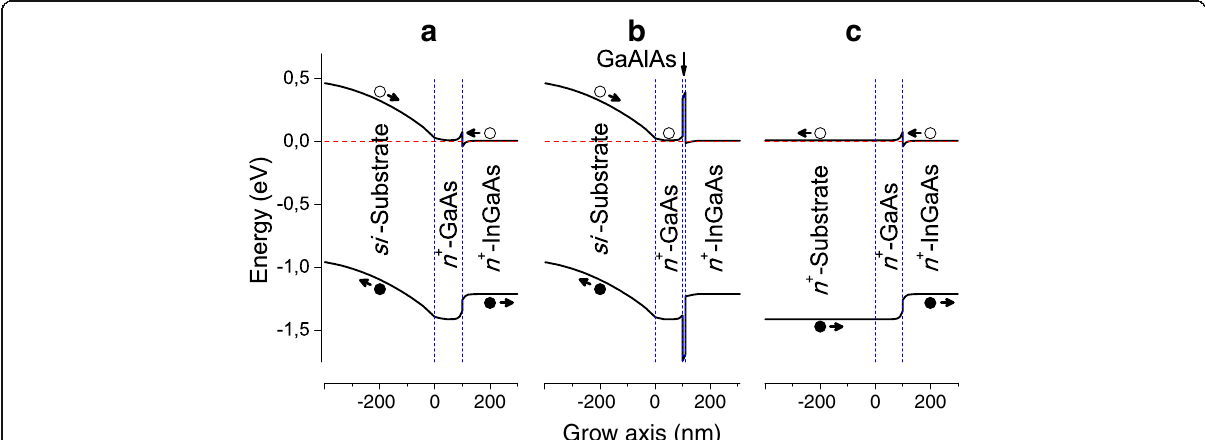
Fig. 5 (Color online) calculated band profiles near In 0.15 Ga 0.85 As/GaAs interfaces of the metamorphic structure grown on a si -substrate with the n + -GaAs layer thickness of a 100 nm (present sample), b 100 nm and a 10-nm thin Ga 0.3 Al 0.7 As barrier layer, and c structure like the present but grown on a n + -substrate doped similar to the 100-nm thick n + -GaAs layer above. The calculations were carried out using Tibercad software